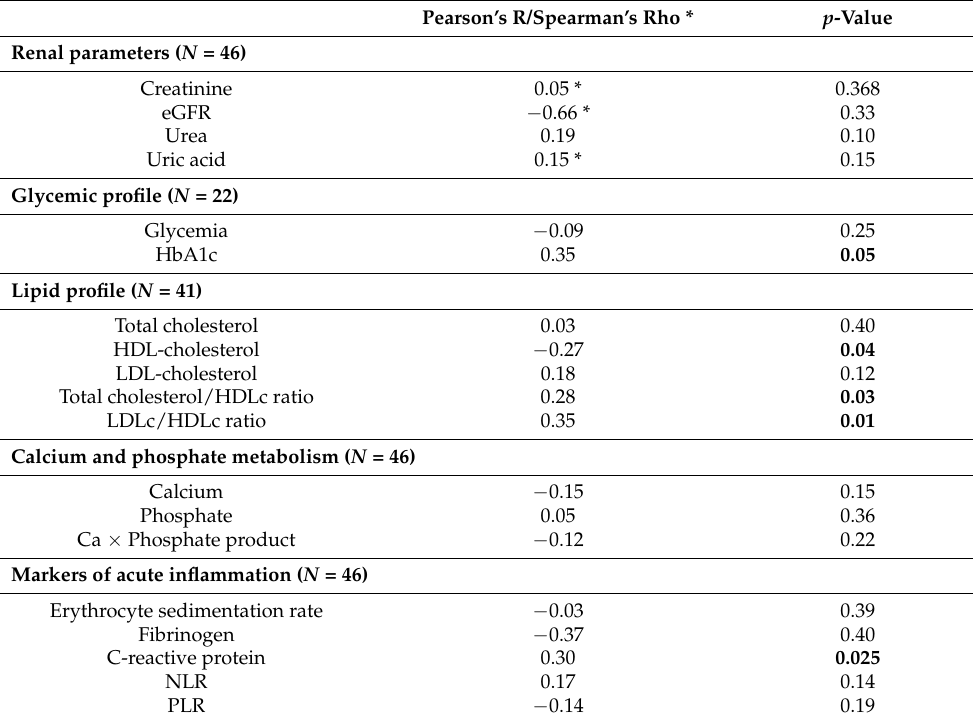
Table 4. Correlations between AOPP levels and various metabolic serum parameters or markers of acute